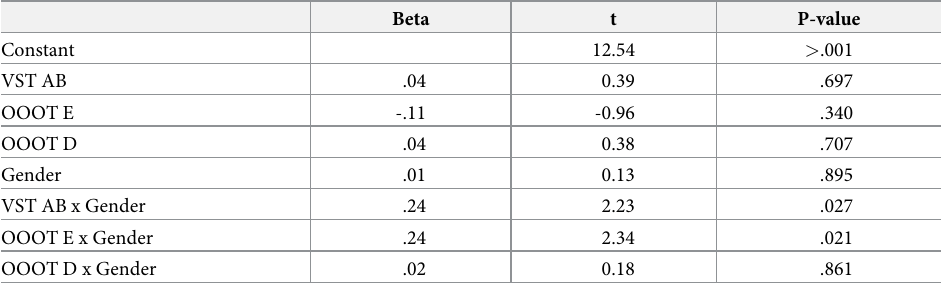
Table 6. Linear model of predictors of frequency of consumed alcohol during the past 30 days. Beta t P-value Constant 12.54